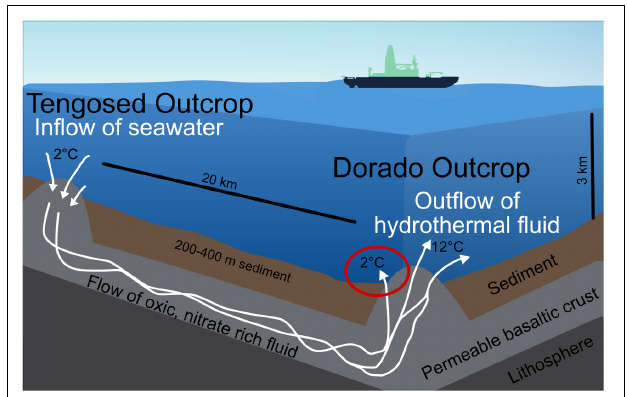
FIGURE 2 | Schematic of the cool hydrothermal system (CHS) at Dorado Outcrop. Seawater enters the crust through recharging outcrops, such as Tengosed, 20 km distance from Dorado Outcrop. This cool seawater flows through the crust for < 3 years before discharging at Dorado Outcrop (Wheat et al., 2017). The red circle denotes the focus of this study, the sediments on and near Dorado Outcrop which experience hydrothermal fluid discharge.